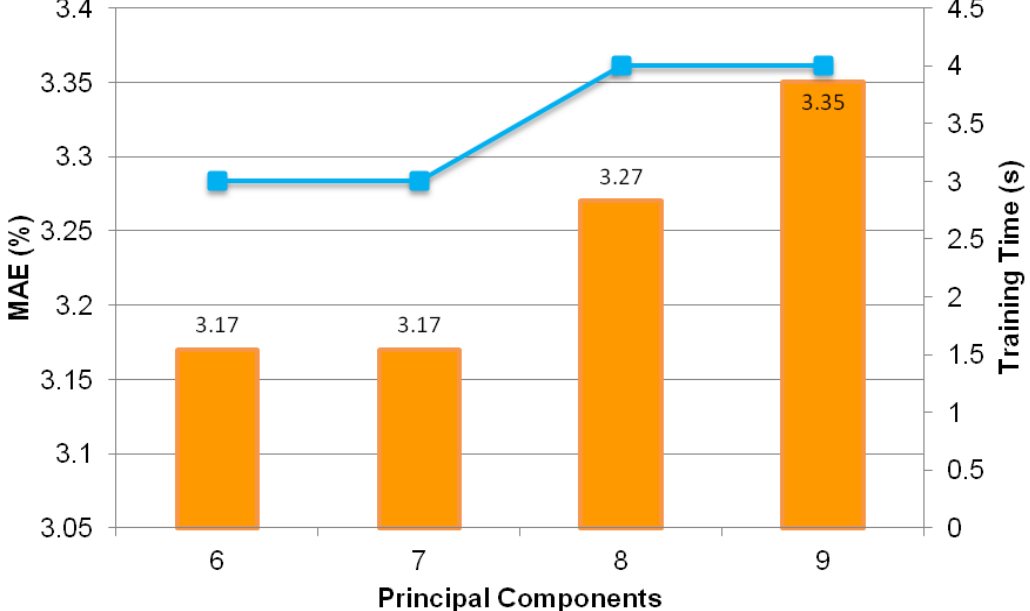
Figure 14. Test set MAE values and training times of MLP trained with six to nine principal